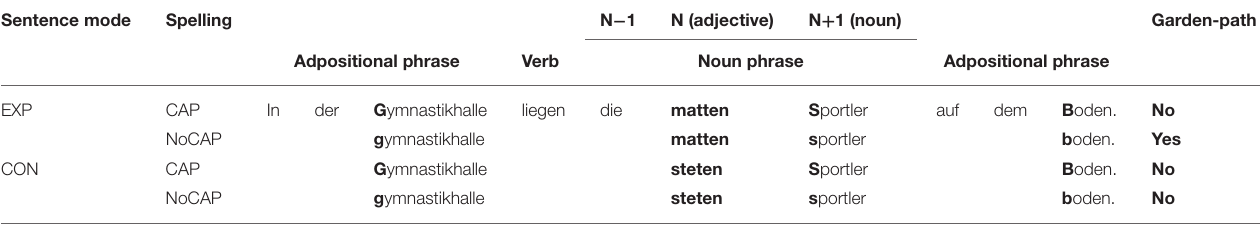
TABLE 1 | Example sentence of EXP and CON in all conditions (differences between the modes are printed in bold letters). Sentence